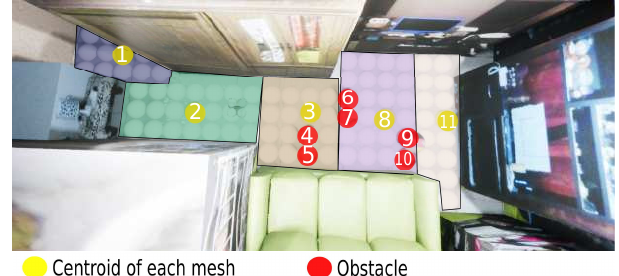
Figure 19. Meshes navigation in a 2D plane.